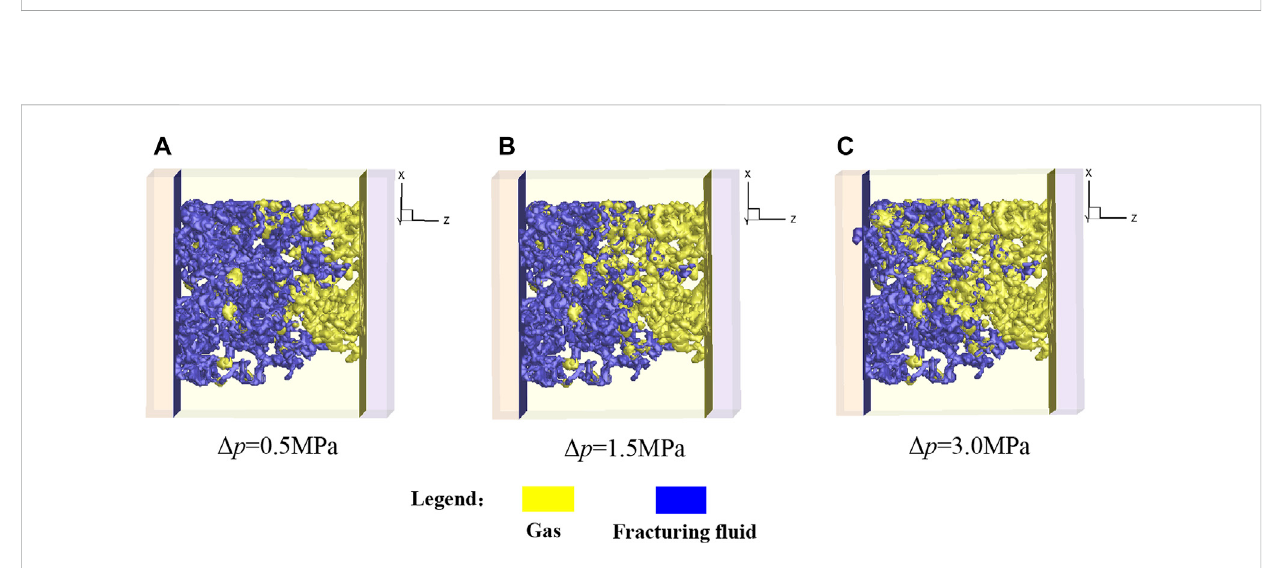
FIGURE 15 Gas-liquid distribution at the equilibrium state ( t (cid:2) 4 . 0 × 10 6 ) in the fl owback process under different fl owback pressure differences. (A) Δ p = 0.5 MPa, (B) Δ p = 1.5 MPa, (C) Δ p = 3.0 MPa.